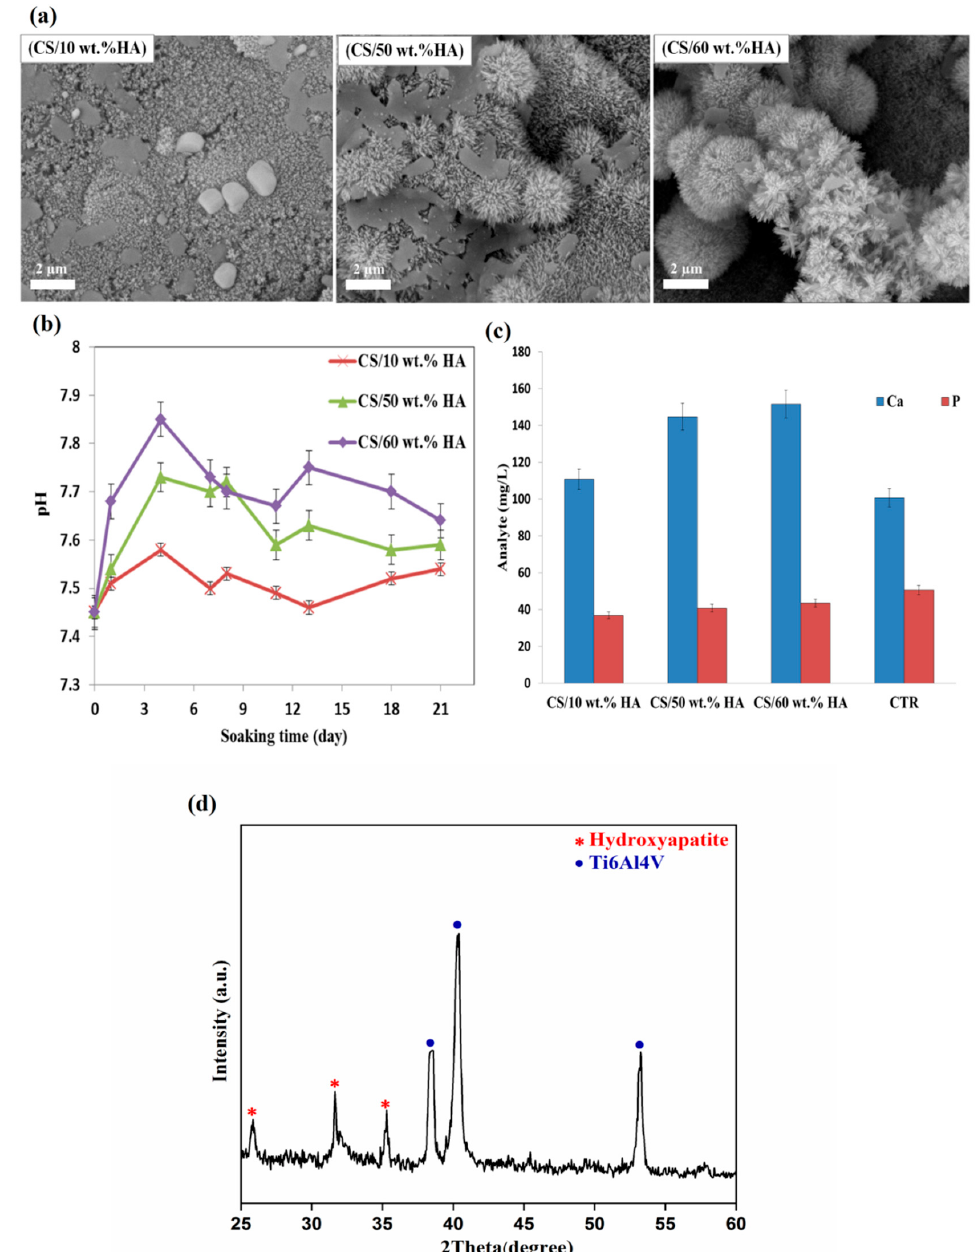
Figure 5. ( a ) SEM images of apatite deposited on the surface of CS-HA coatings immersed in SBF 1X 1X for 21 days ( b ) pH of the SBF solution, after soaking the CS / HA coatings ( c ) Ca and P ions for 21 days ( b ) pH of the SBF solution, after soaking the CS/HA coatings ( c ) Ca and P ions concentrations of the CS / HA coatings after 21 days soaking ( d ) XRD pattern of CS / 60 wt.% HA coating concentrations of the CS/HA coatings after 21 days soaking ( d ) XRD pattern of CS/60 wt.% HA coating after 21 days after 21 days soaking.